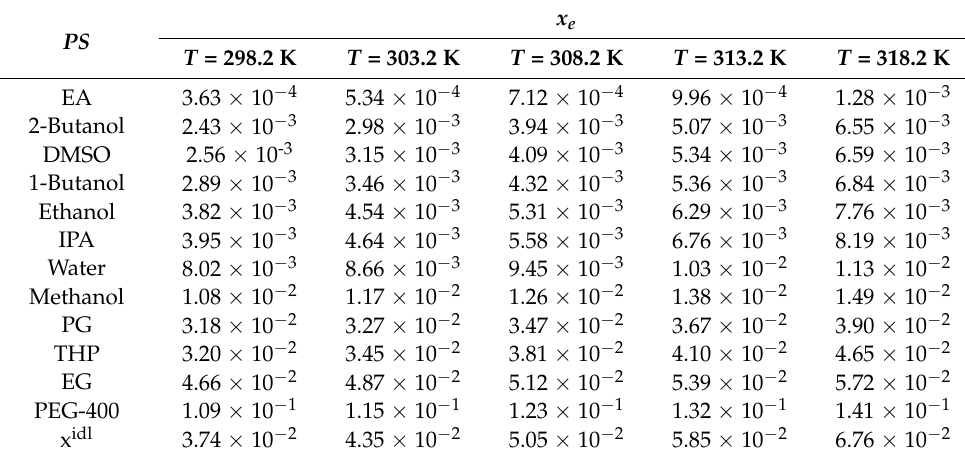
Table 1. Experimental solubilities ( x e ) of emtricitabine (ECT) in mole fraction in various pure solvents ( PS ) at T = 298.2 K to 318.2 K and p = 0.1 MPa a . x e PS T = 298.2